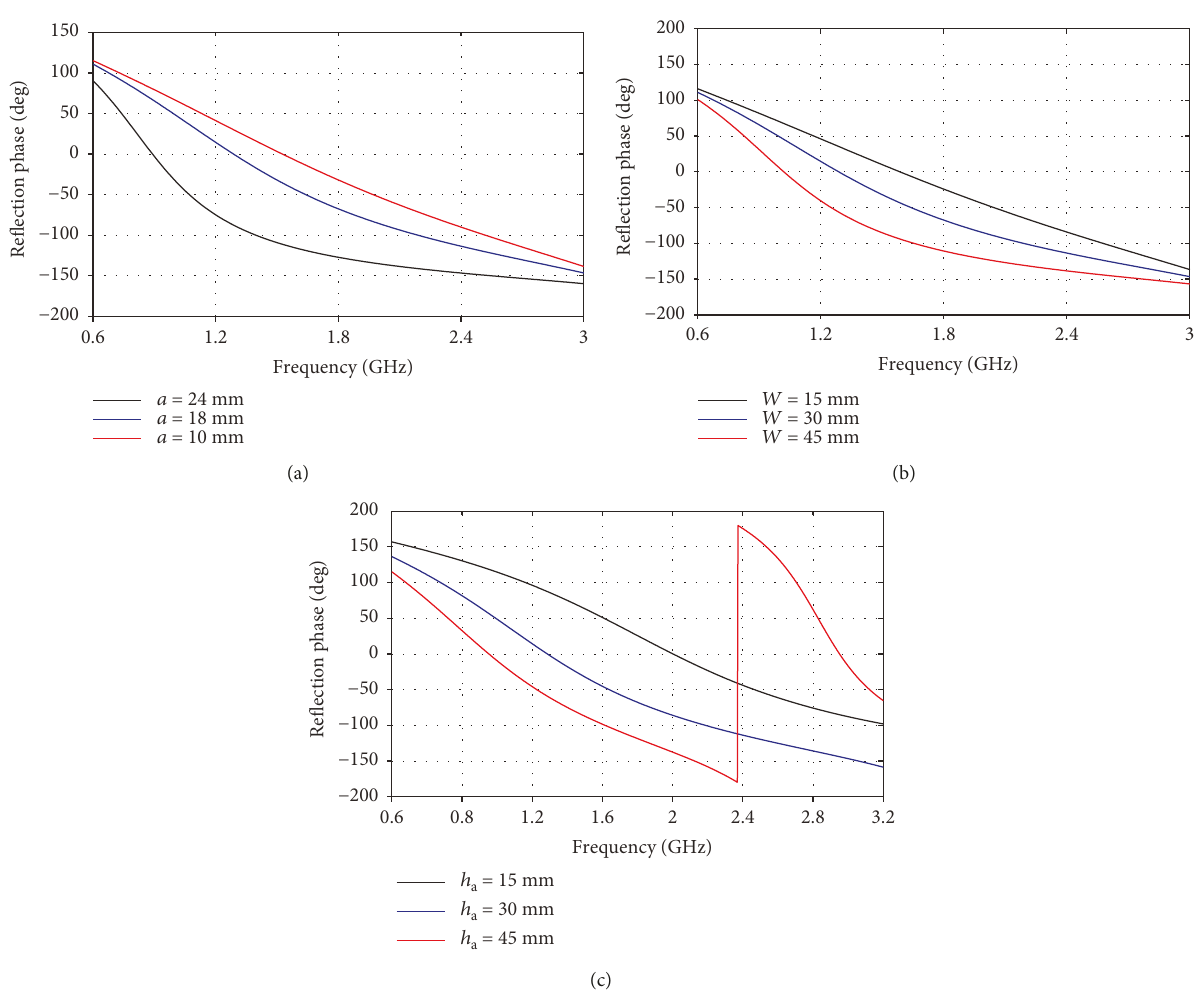
Figure 8: Simulated re fl ection phases of AMC with changes in (a) a , (b) W , and (c) h